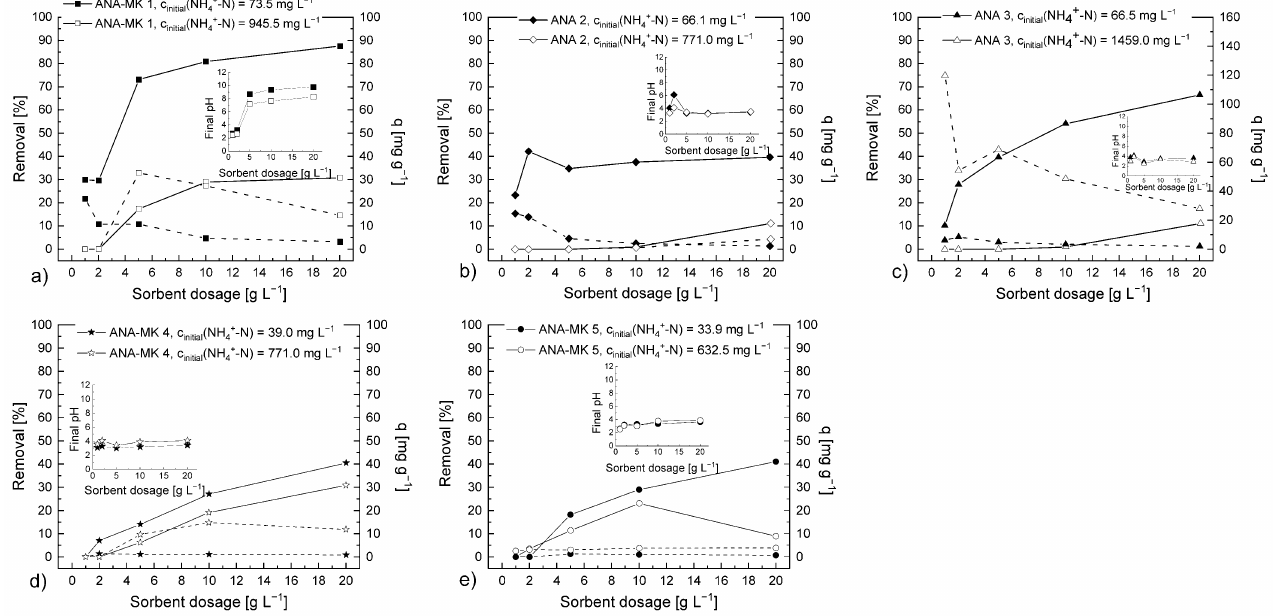
Figure 6. Effect of sorbent dosage on the ability of ( a ) ANA-MK 1, ( b ) ANA 2, ( c ) ANA 3, ( d ) ANA-MK 4, and ( e ) ANA-MK 5 to remove NH 4+ ions under two different initial NH 4+ ion concentrations. The removal percentage of NH 4+ ions is represented by a solid line, and the sorption capacities ( q e ) are represented by a dashed line. Experimental conditions: sorbent dosage: 1–20 g L − 1 ; initial pH of the solution: 2.5 (pH was adjusted after the addition of sorbent to the solution); contact time: 24 h; and temperature: 22 ◦ C–23 ◦ C. Analysis was based on the concentrations of NH 4+ -N.